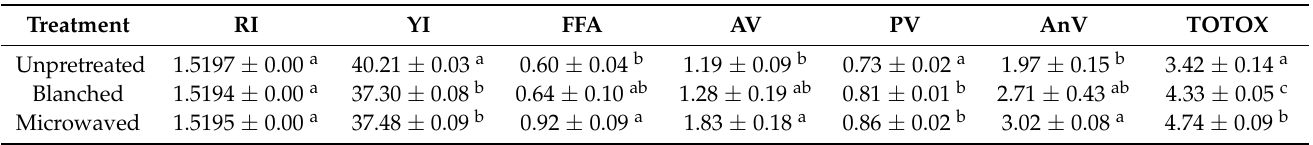
Means ± standard deviation of analysis ( n = 3). Different superscript letters in the same column indicate significant difference ( p < 0.05) according to Duncan’s multiple range test. RI = refractive index (25 ◦ C), YI = yellowness index, FFA = free fatty acid as punicic